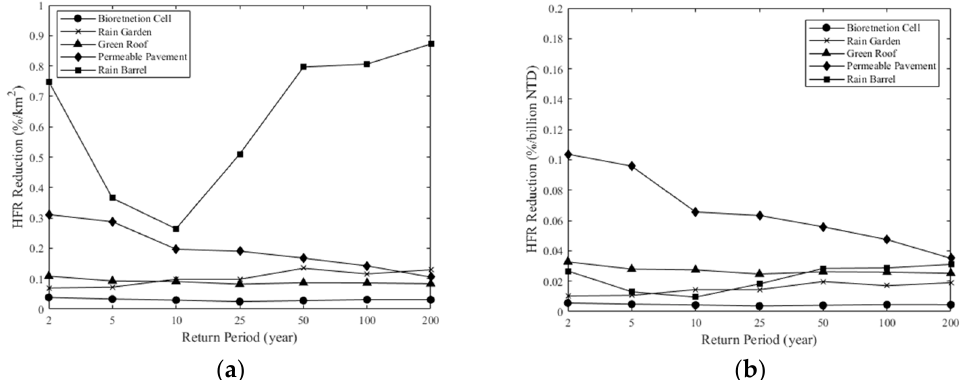
Figure 6. The flood peak reduction by different LID components for the six-hour rainfall duration and different return periods: (a) percentage of the peak flow reduction for unit area in 6-hour rainfall; ( b ) percentage of the peak flow reduction for unit cost in 6-hour rainfall.